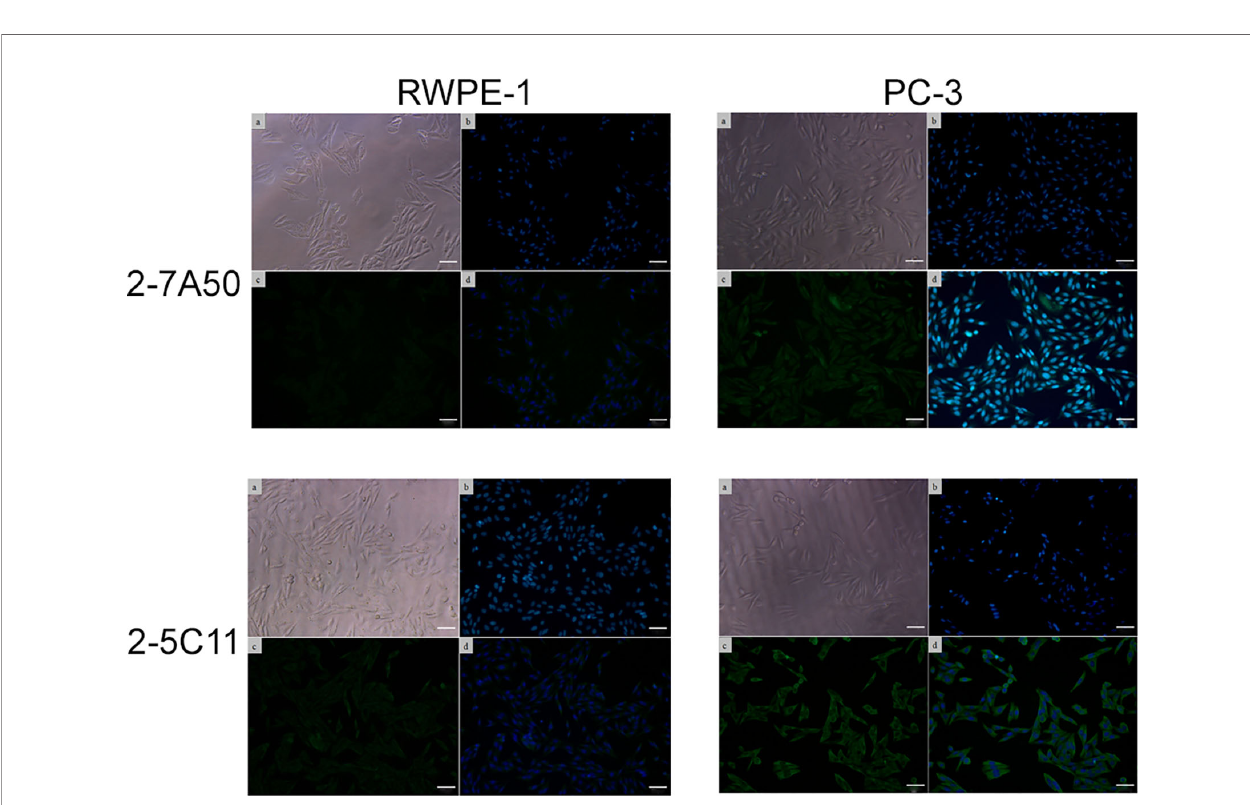
FIGURE 4 | Indirect immuno fl uorescence of mAbs 2-7A50 and 2-5C11 against tumoral and non-tumoral cell lines. (a) cells under light microscopy; (b) nuclei stained with Hoechst 33342; (c) mAb staining; (d) mAb + nuclei staining. High reactivity is shown, for both mAbs, against the tumoral cell line. Low to none reactivity to the non-tumoral cell line is present. In both mAbs, a diffuse staining pattern is